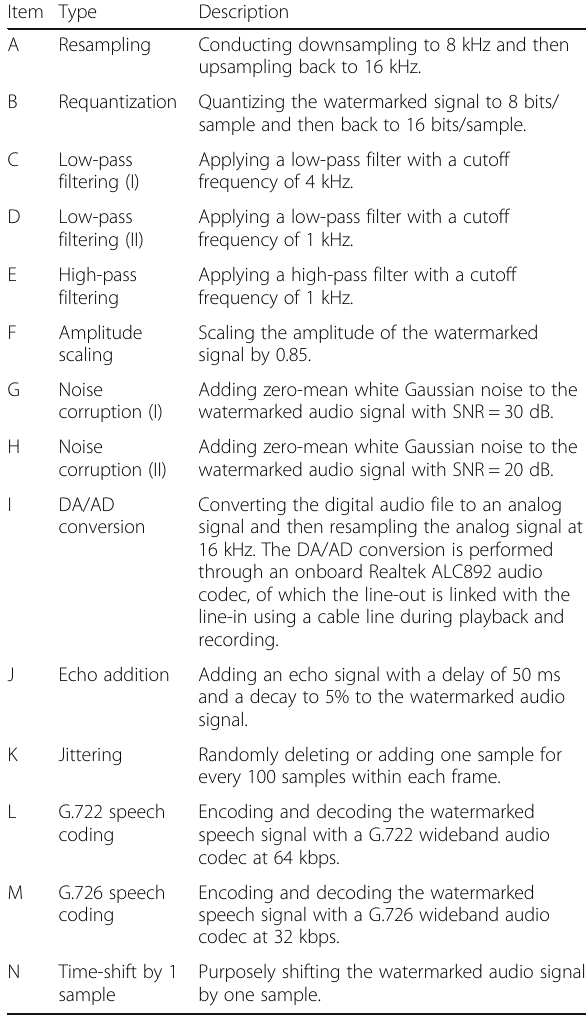
Table 2 Attack types and